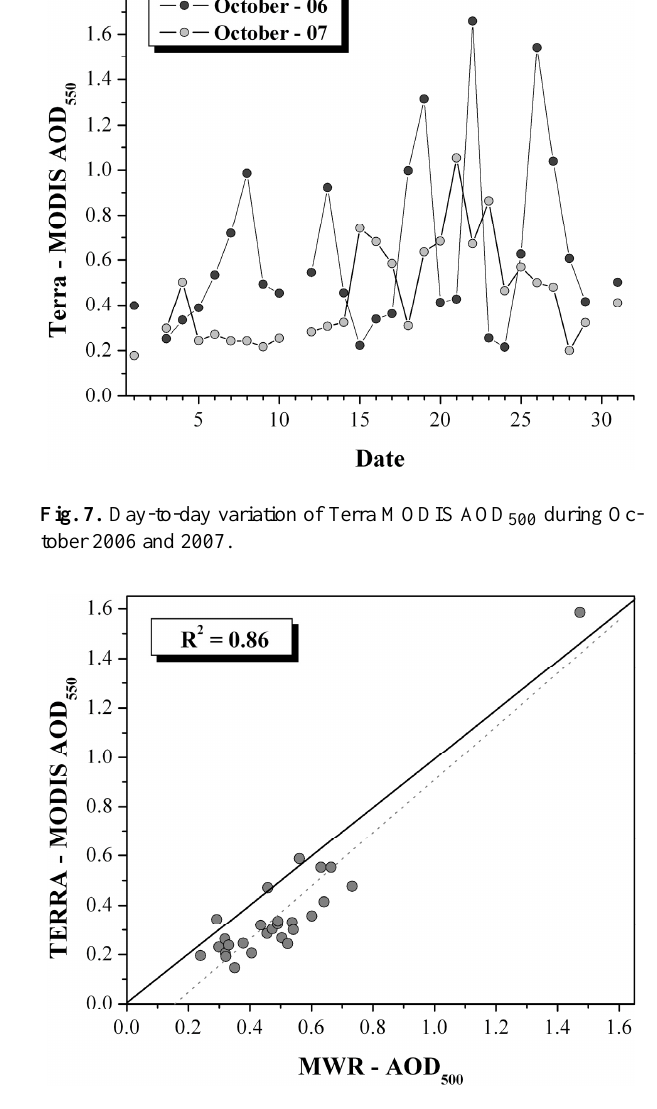
Fig. 8. Scatter plot of MODIS AOD 550 vs. MWR measured AOD 500 over Patiala city, Punjab state,